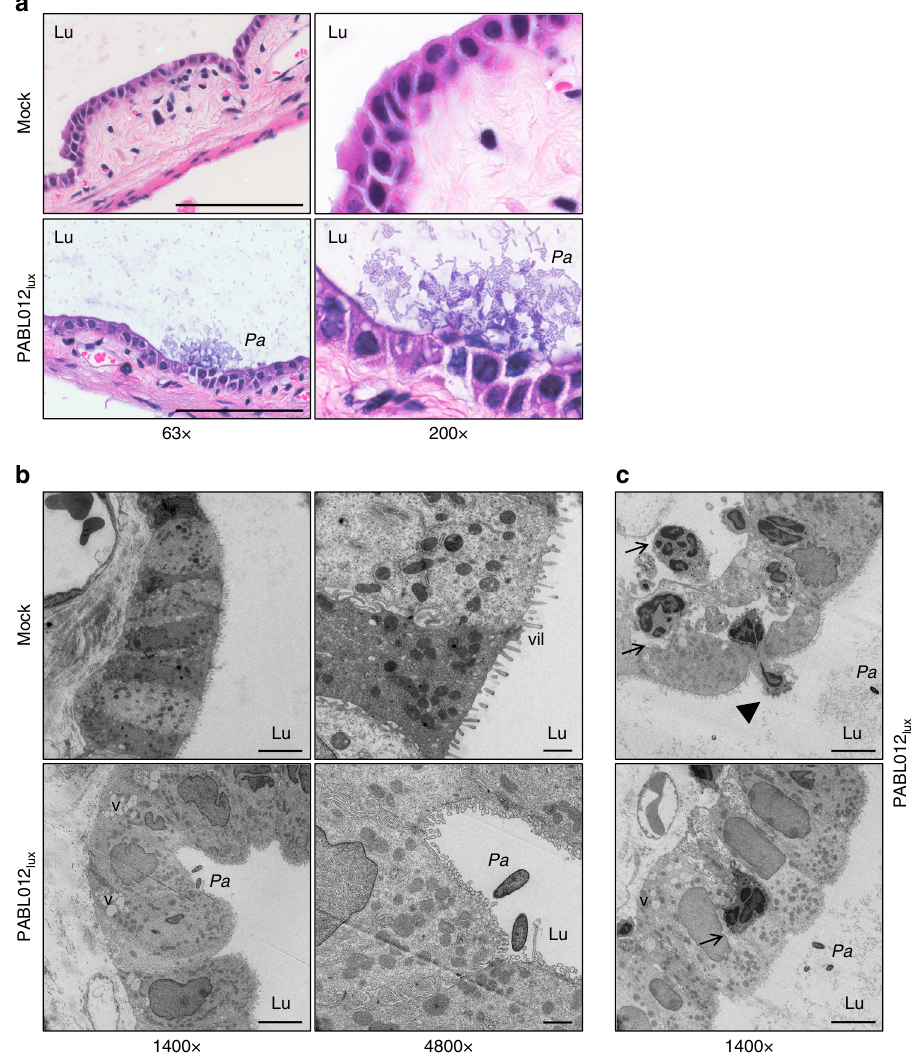
Fig. 4 P. aeruginosa infection damages the gallbladder epithelium. BALB/c mice intravenously infected with PABL012 lux (~2 × 10 6 CFU) were euthanized at 24 hpi to harvest gallbladders for histological preparation. a Hematoxylin & eosin (H&E) staining of mock (PBS) or PABL012 lux -infected mouse gallbladder sections at ×63 and ×100 (scale bar = 100 µ M). b , c TEM of gallbladder sections from mock (PBS) or PABL012 lux -infected mice (scale bars = 5 µ M (×1400), 1 µ M (×4800)). Black arrows indicate neutrophils, the black arrowhead shows a transmigrating neutrophil extravasating into the gallbladder lumen. Lu (lumen), V (vacuoles), vil (villi), Pa ( P. aeruginosa)